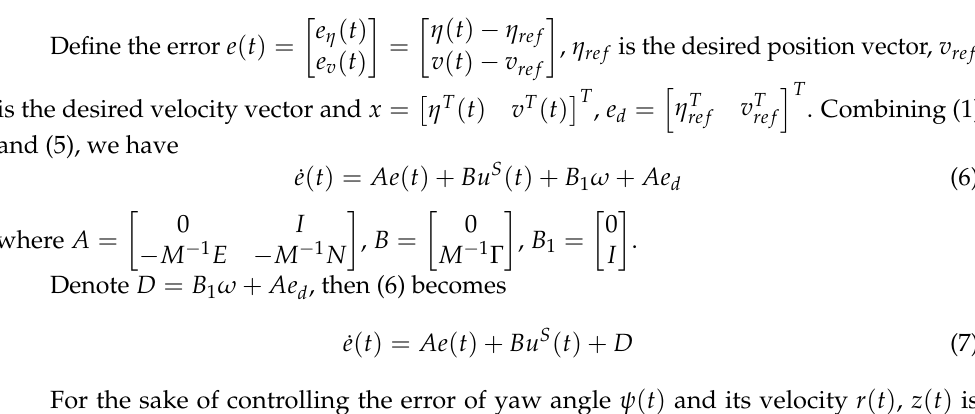
Figure 1. UMV system in the reference coordinate